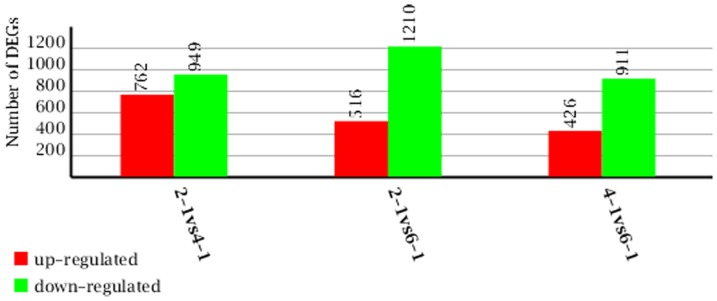
Numbers of DGE unigenes in each comparison (2-1: 48 h, 4-1: 100 h, 6-1: 148 h).Up-(red) and down-regulated (green) unigenes were quantified.